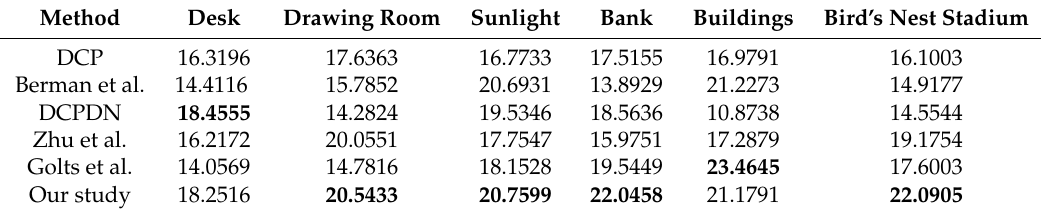
Table 2. Comparison of PSNR of the dehazed images from Figures 6–11.